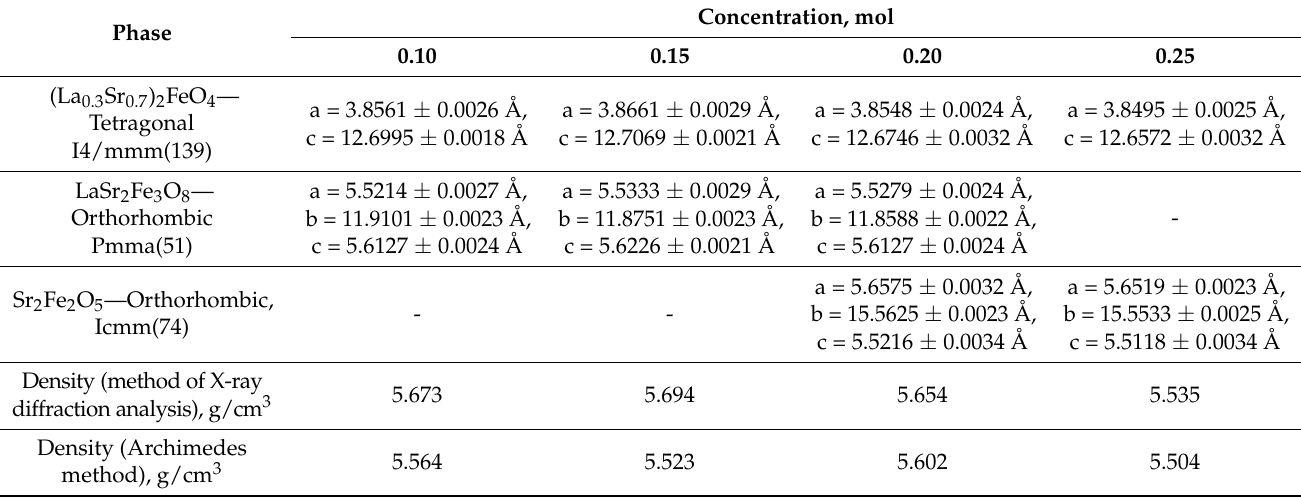
Table 2. Structural parameter